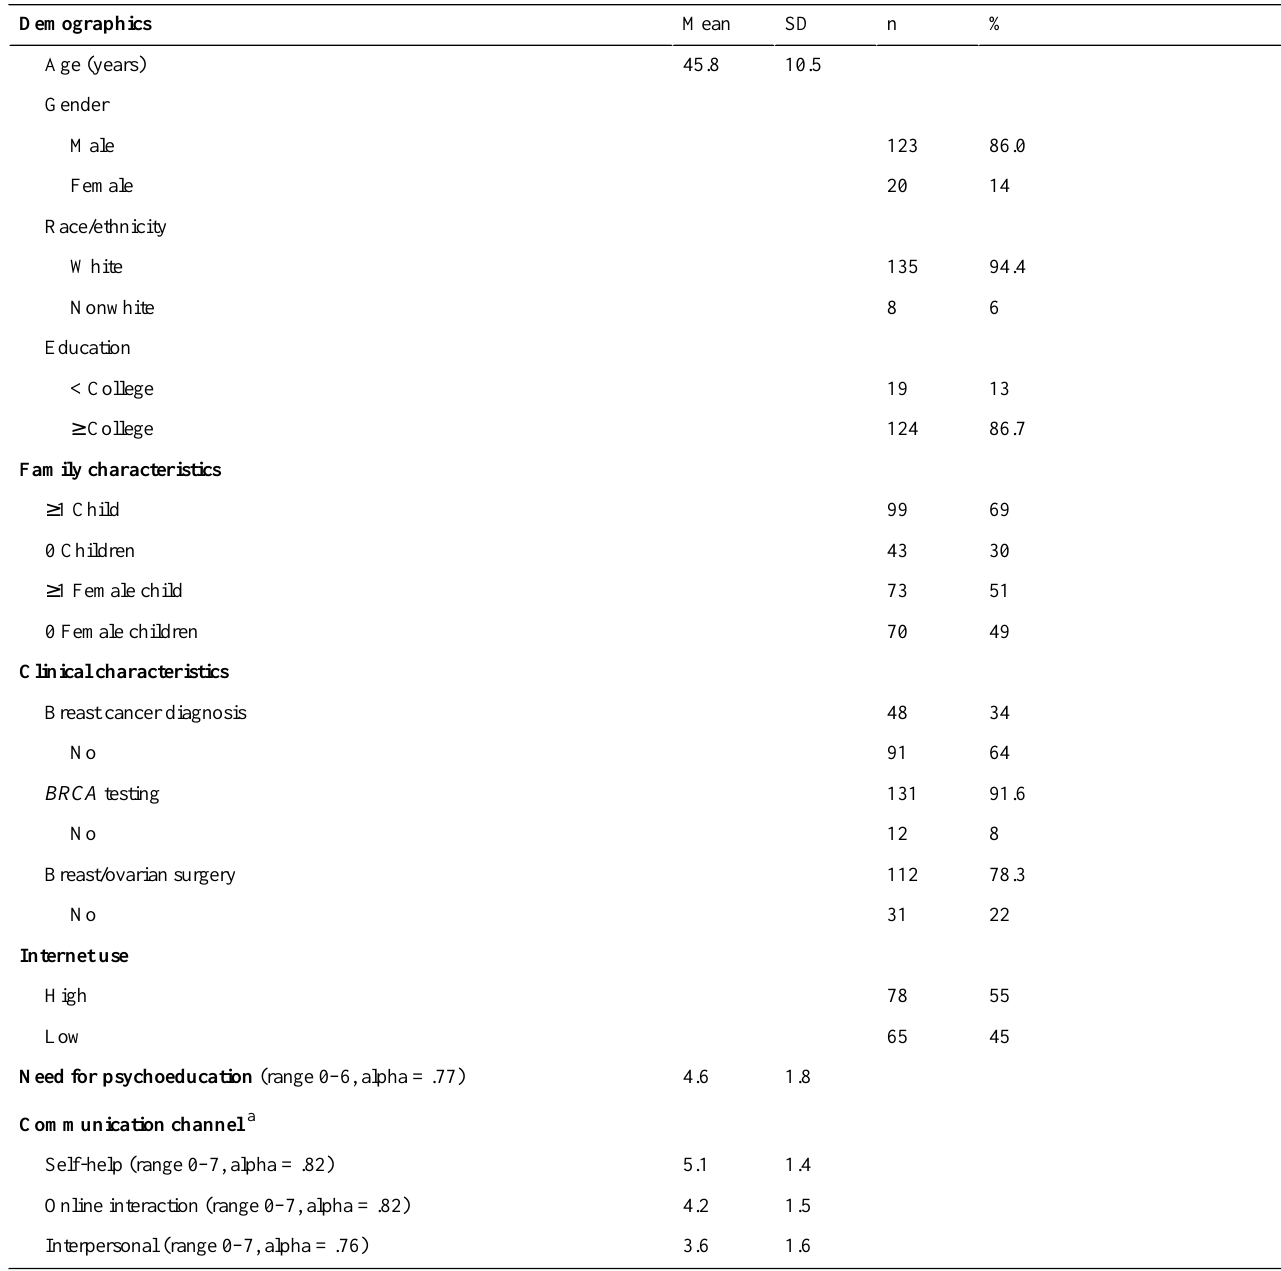
Table 1. Sample characteristics (n =